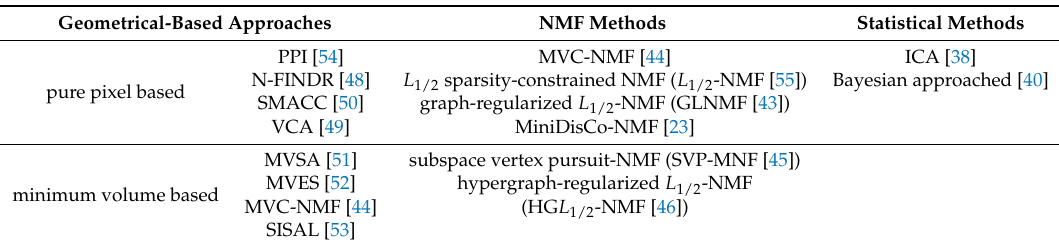
Table 1. Categories of endmember extraction and unmixing methods. The methods marked with blue can be applied to endmember extraction, and methods marked with purple are suited for both endmember extraction and unmixing. PPI, pixel purity